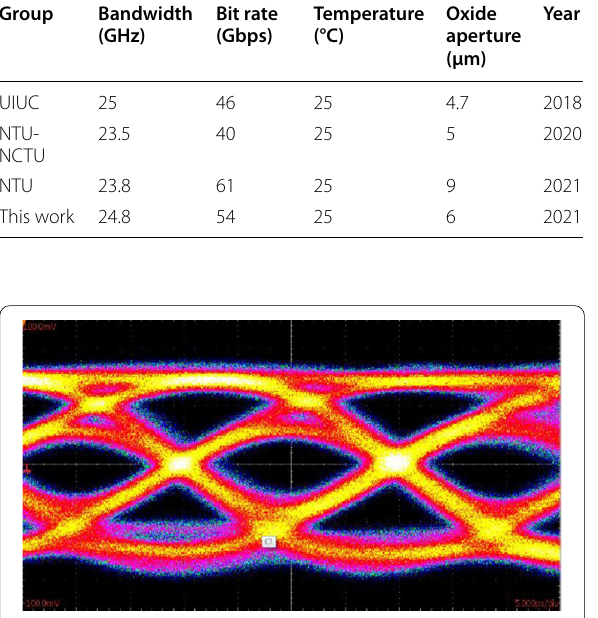
Fig. 7 Eye‑diagrams of 53 Gb/s error‑free transmission up to 100 m with the 6 μm diameter of oxide aperture in the VCSEL after